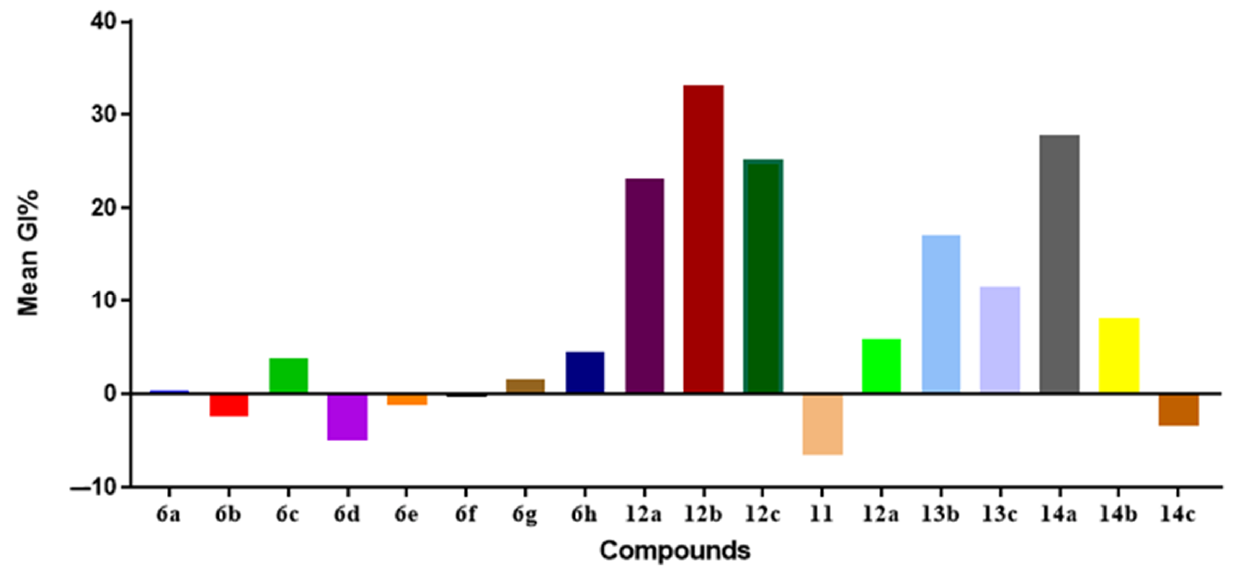
Figure 4. Mean GI% of compounds 6a – h, 12a – c, 11, 13a – c , and 14a – c against the NCI-59 cell line panel.